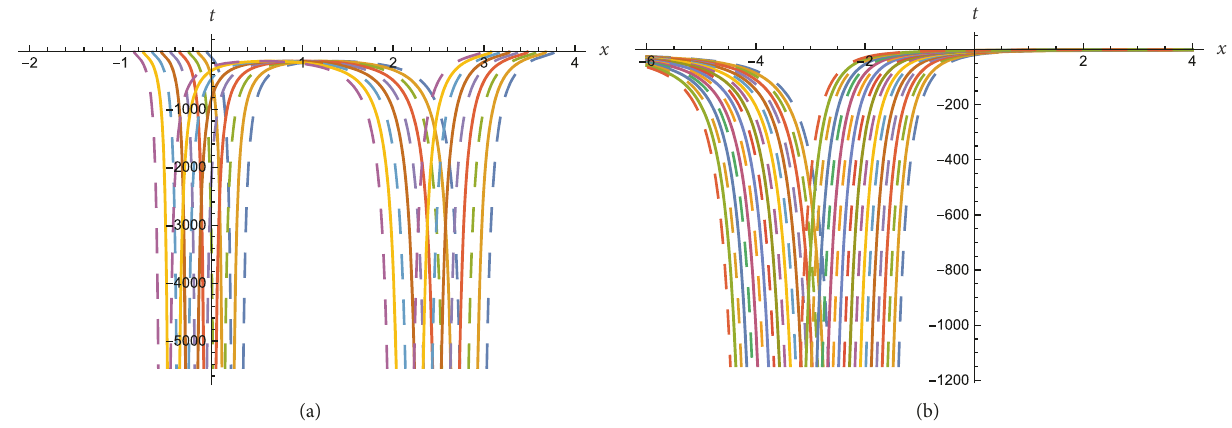
Figure 9: Plot of the exact traveling wave solutions of (a) periodic solitary wave solution (47) with parameters 𝑎 1 = 9; 𝑙 2 = −3; 𝑙 3 = −3; 𝑙 4 = 1;𝜅 = 0.7;𝑐 = 0.1; 𝑦 = 0.8 ; (b) dark solitary wave solution (49) plotted at 𝑎